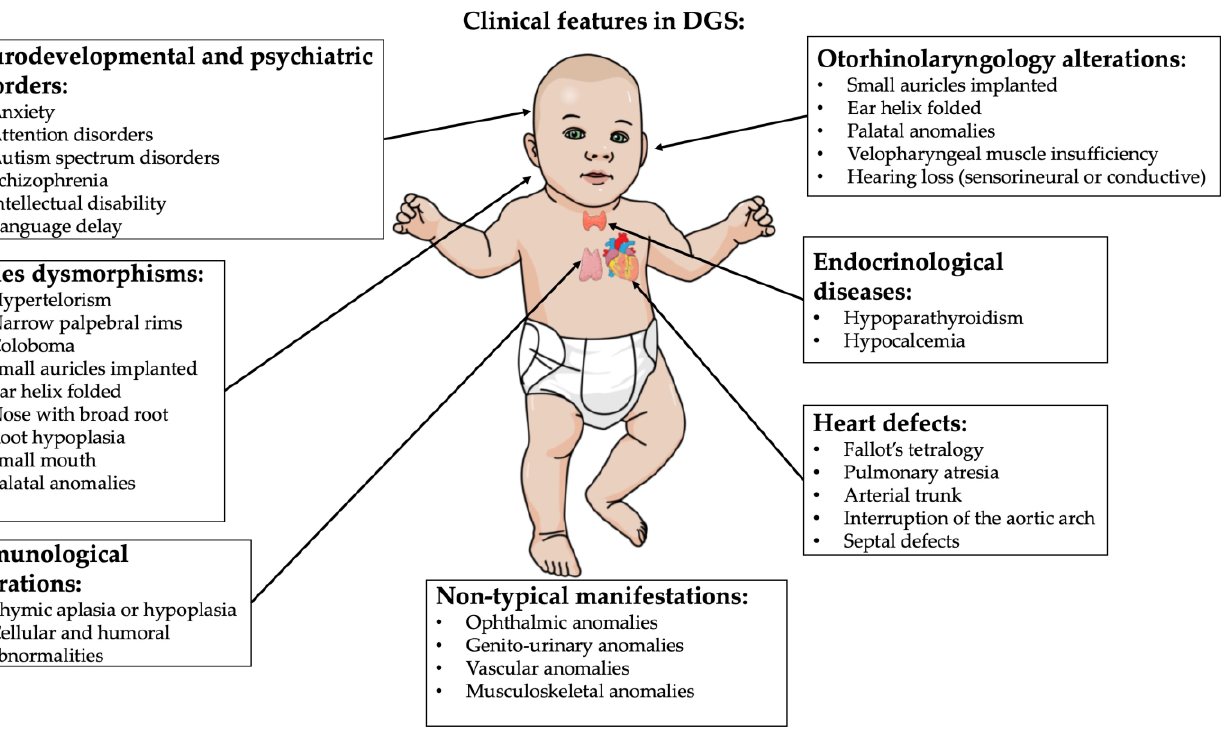
Figure 2. DGS typical clinical features. Image created by mindthegraph.com platform.